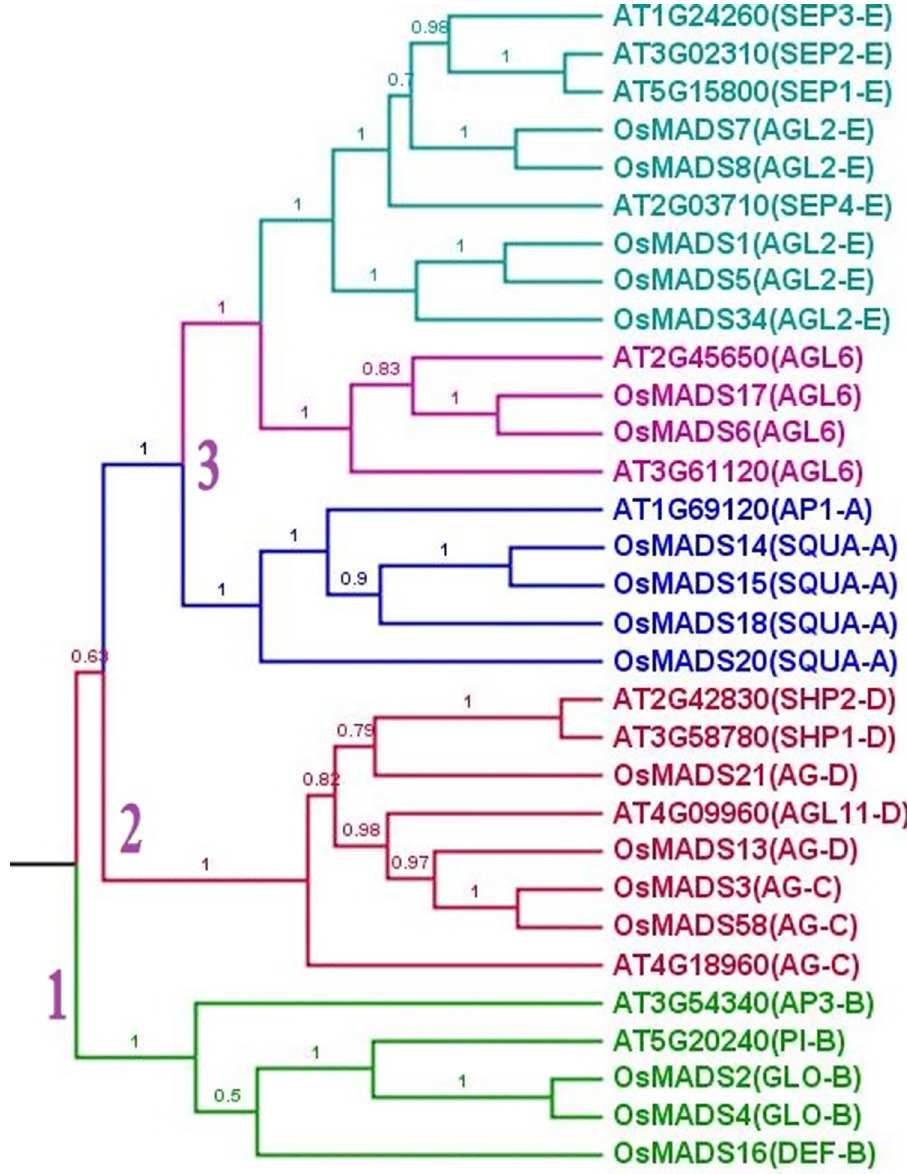
Fig 3. Phylogeny of the ABCDE and AGL6 genes from A . thaliana and O . sativa and 31 classified protein sequences obtained using BEAST. The genes are indicated as follows: A gene, blue; B gene, green; CD gene, red; E gene, green; AGL6 , pink. The Bayesian posterior probability values in tree. By using the BEAST tool, ABCDE and AGL6 genes appeared in the following order: B gene ! CD gene ! AGL6 /E/A gene. The numbers 1, 2, 3 represent the order of evolution of ABCDE and AGL6 genes. TreeAnnotator (v. 1. 8), with the first 1000 trees discarded as burn-in, and visualized using Fig- tree (v. 1. 4) [27].